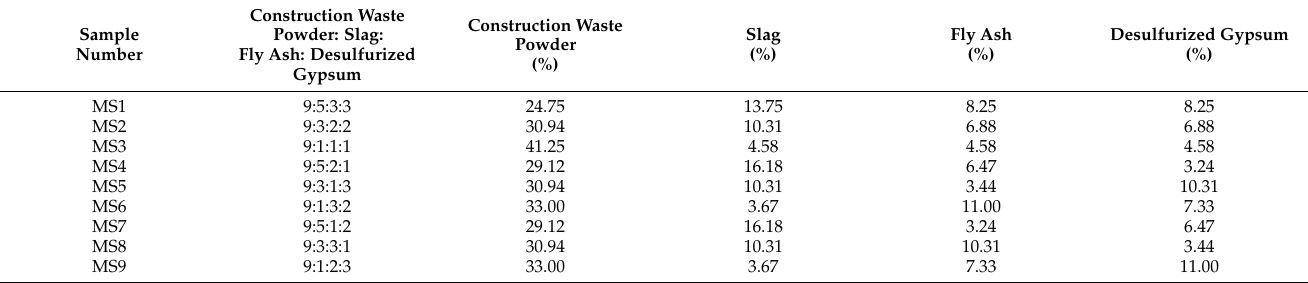
Table 2. Material proportioning table for MS1–MS9